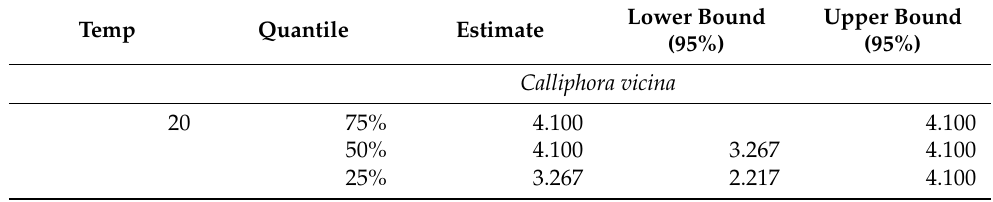
Table 2. Estimates of LT50 and LT75 (lethal time to 50% or 75% survivorship) and 95% confidence limits, at 5 temperatures for 3rd-stage larvae under anoxia for each of 4 species: Calliphora vicina , Cochliomyia macelleria , Lucilia sericata , and Phormia regina